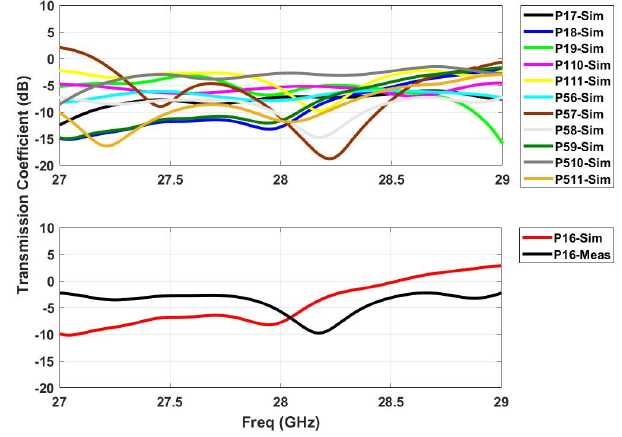
Figure 8. Simulated transmission coefficients ( top ) when ports 1 and 5 are active with measurement verification on a single port (P16) ( bottom ).